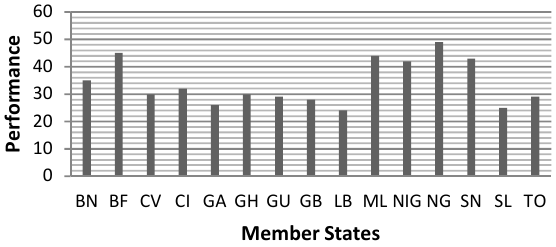
Figure 2. - Geospatial performance of ECOWAS Member